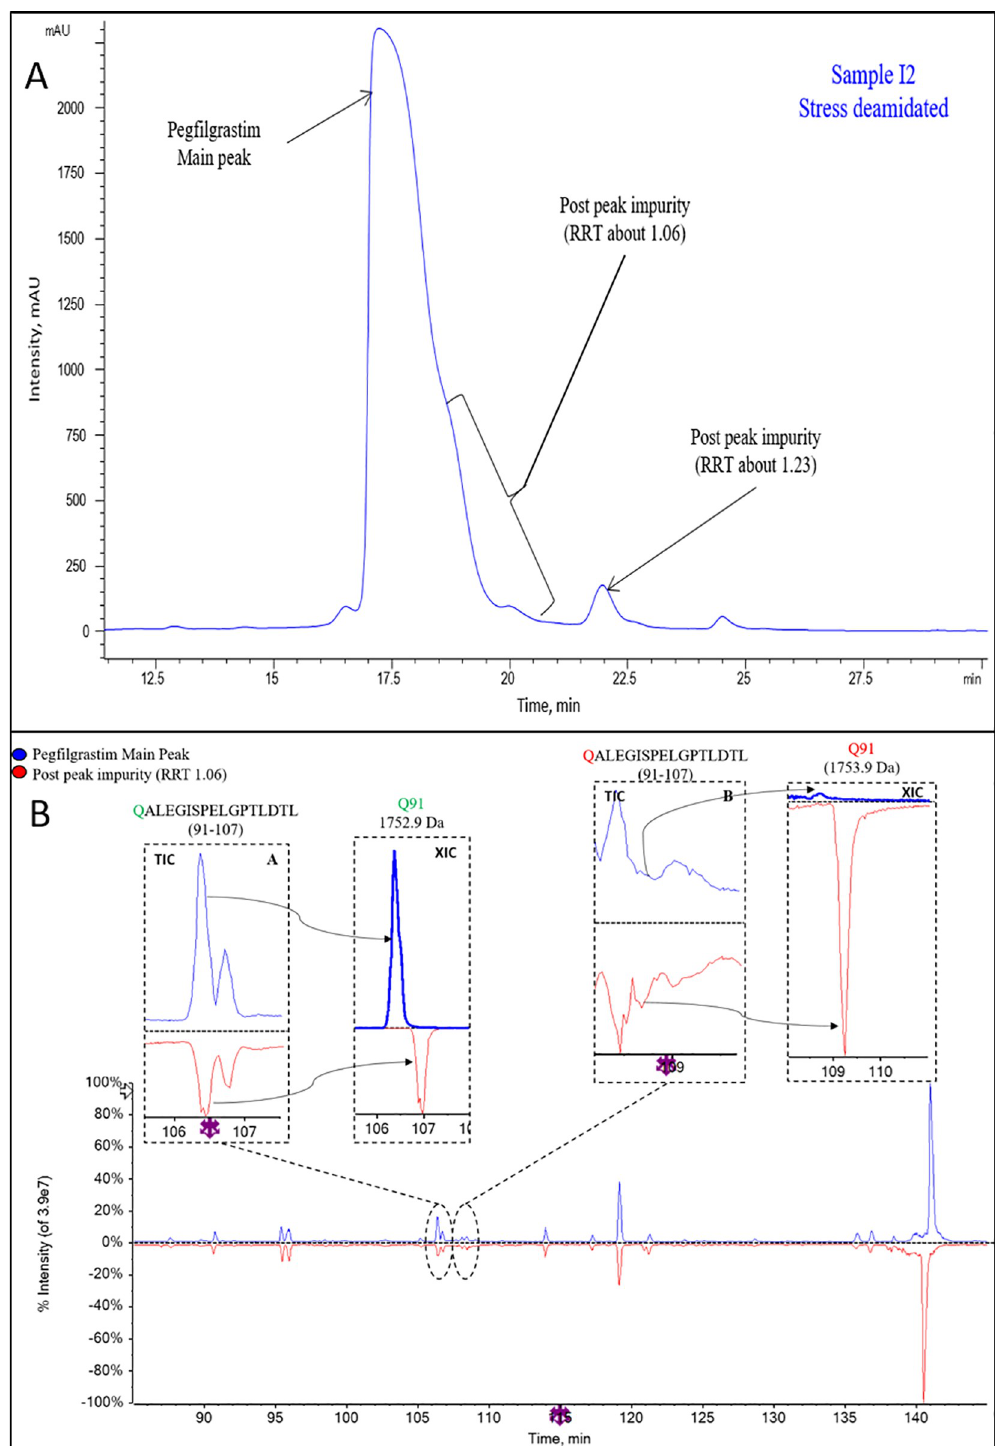
Fig 13. (A) Representative RP-HPLC profile of stressed deamidated INTP5 (Sample I2) for peak collection. (High loading- 500 μ g) (B) Overlay of pegfilgrastim main peak and Post-peak Impurity (RRT about 1.06), TIC of peptide mapping (85–145 min) for peptide containing